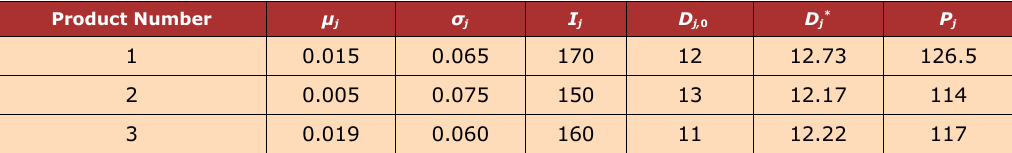
Table 1. Binary model parameter values in ( r = 5%) D j,A